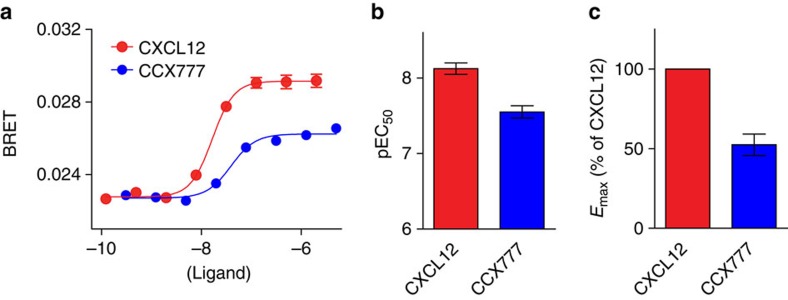
Functional characterization of CXCL12 and CCX777.(a) Dose–response curves of β-arrestin-2-GFP10 recruitment to ACKR3-Rluc3 in HEK293 cells. Curves are representative of 10 independent experiments and error bars represent standard errors of the mean of three replicates. (b, c) pEC50 and Emax values determined as the average and standard error of the mean of 10 independent experiments. Emax values were determined as the difference between the start and end values of dose–response curves and were normalized to CXCL12. CCX777 has lower Emax and pEC50 than CXCL12 as determined from two-sided, unpaired t-test with P=0.002 and P<0.0001, respectively.